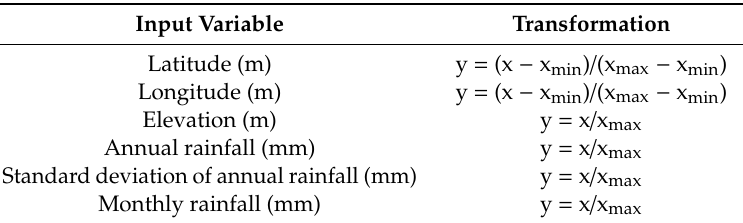
Table 2. Transformation of